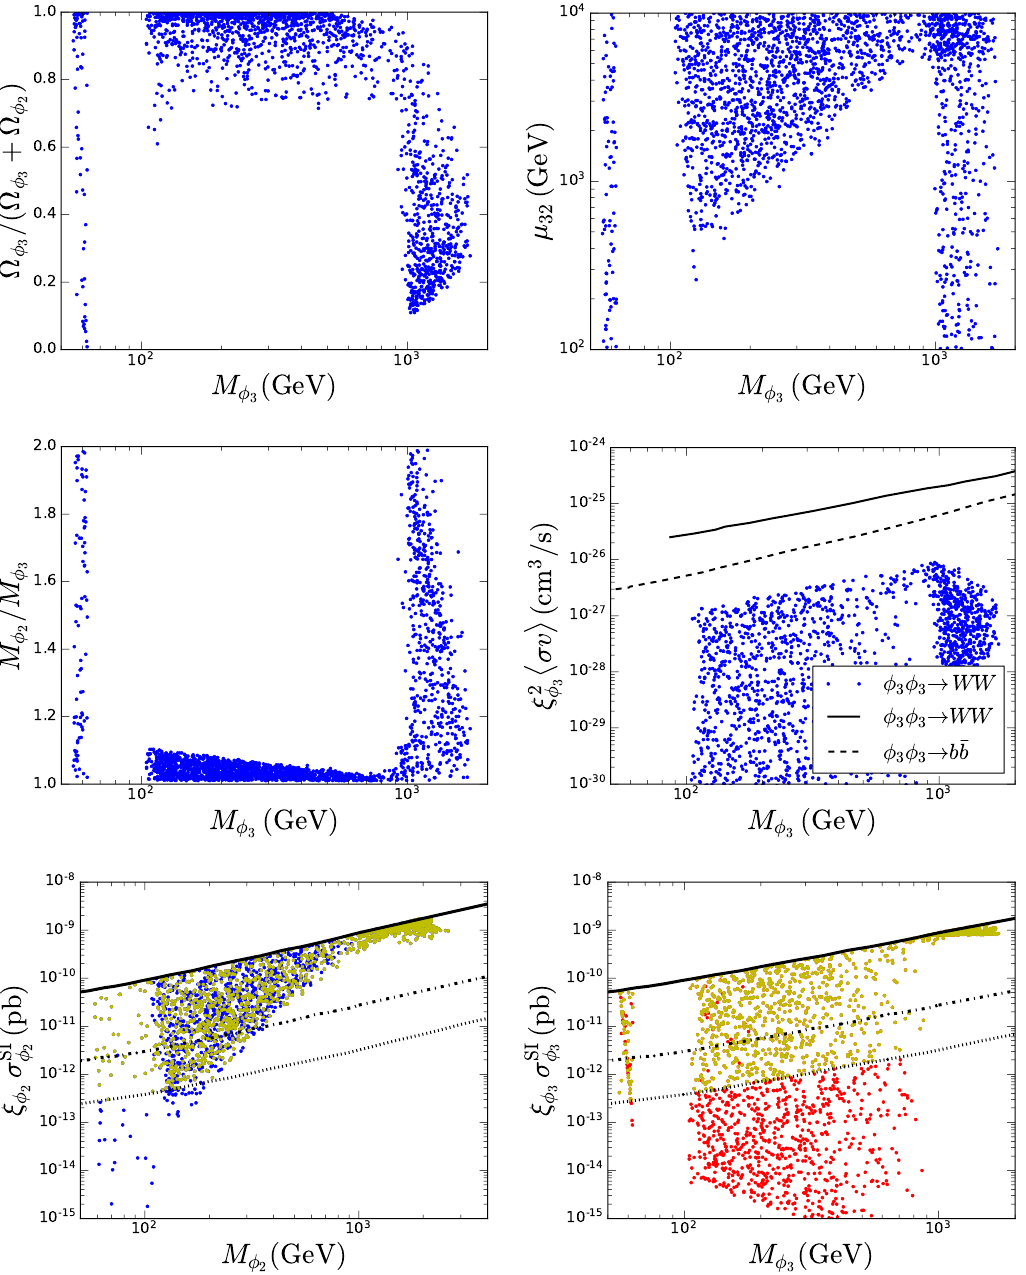
Figure 9 . A sample of viable points of the Z 6 (23) model with M φ dimensions. The top panels show scatter plots of M φ In the center panels, the ratio of dark matter masses (left) and the most relevant indirect detection signal (right) are illustrated. The direct detection prospects are shown in the bottom panels for φ 2 (left) and φ 3